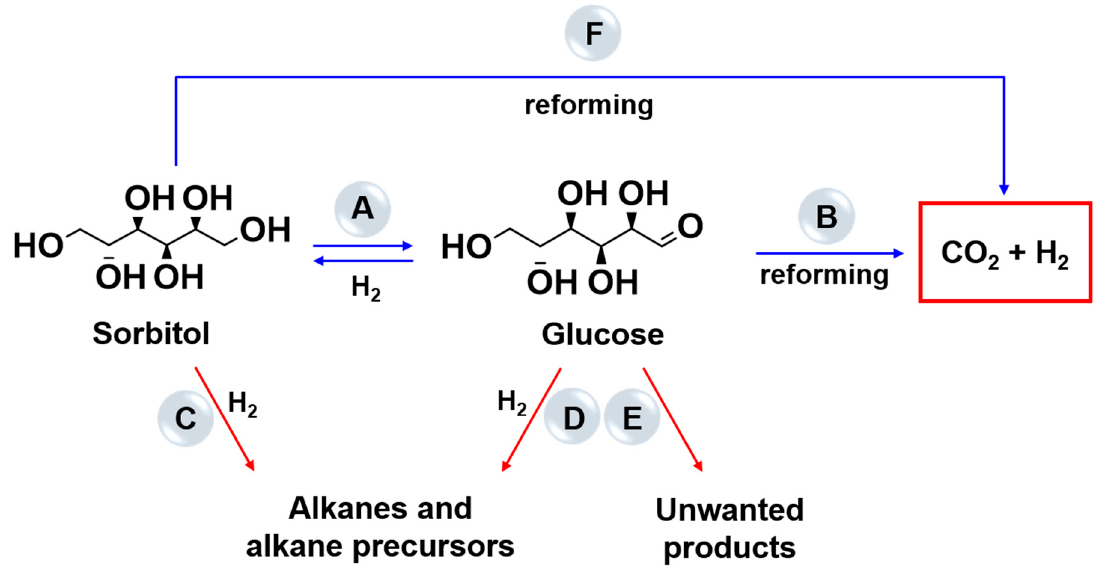
Scheme 4. Possible reactions involved in glucose and sorbitol reforming. Desired and undesired pathways are highlighted in blue and red respectively. Adapted with permission from [47]. Copyright